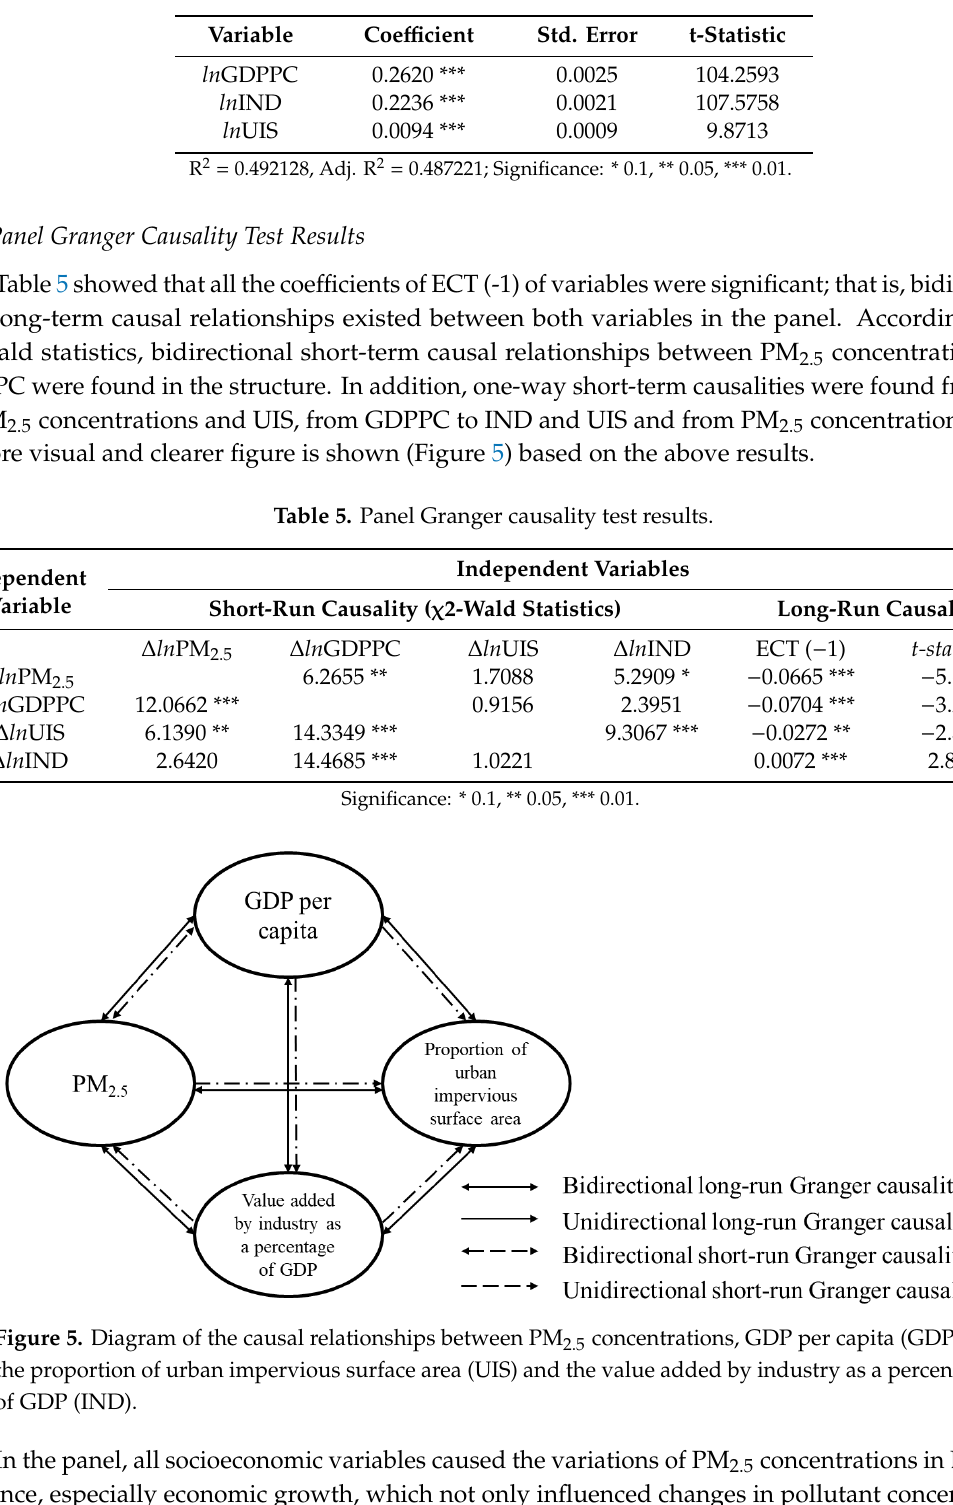
Table 4. Panel fully modified least squares regression results.